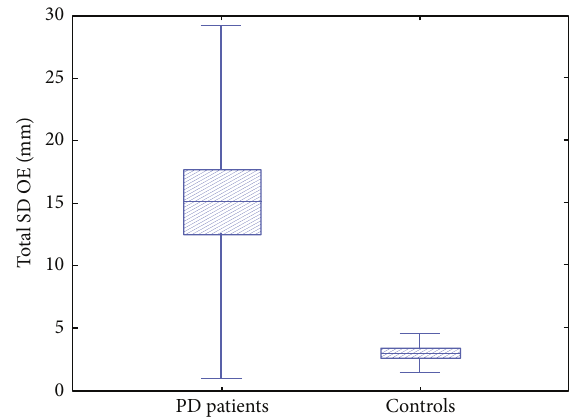
Figure 2: Total standard deviation of trunk sway with open eyes in PD patients with respect to controls. PD patients showed higher values of total standard deviation (SD) of trunk sway with open eyes (OE) with respect to controls.